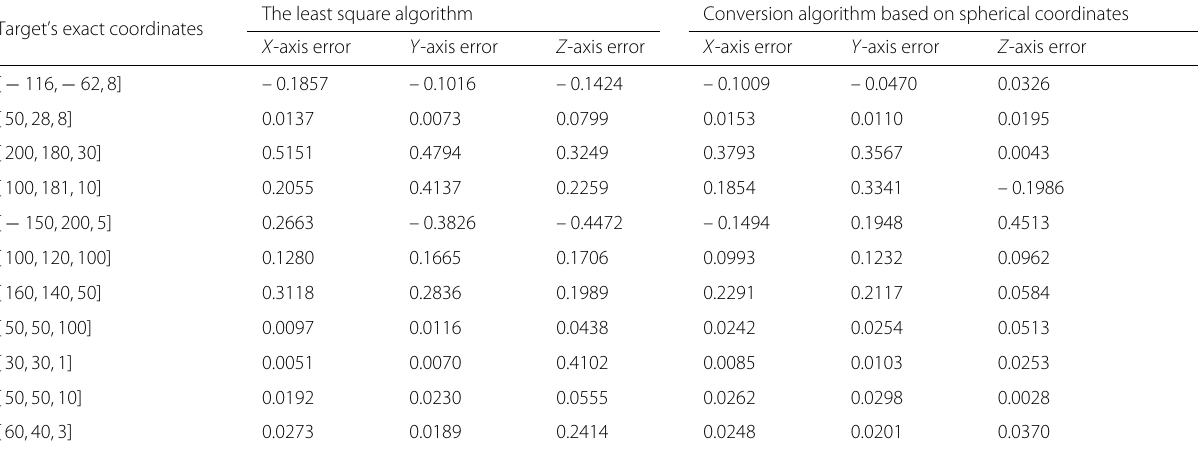
Table 1 Accuracy comparison between the two location algorithms The least square algorithm Conversion algorithm based on spherical Target’s exact coordinates